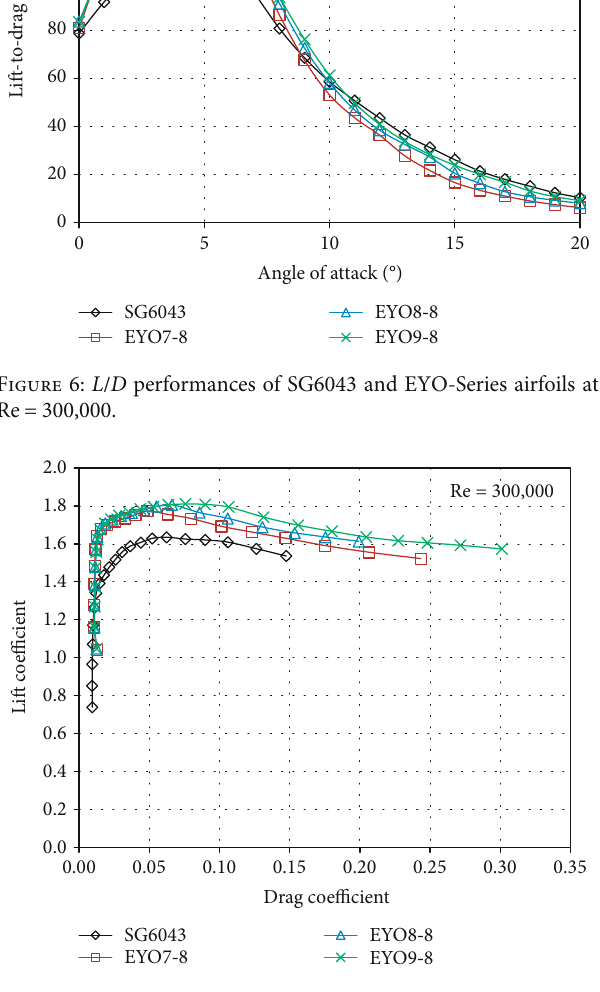
Figure 7: Drag buckets for SG6043 and EYO-Series airfoils at Re = 300,000